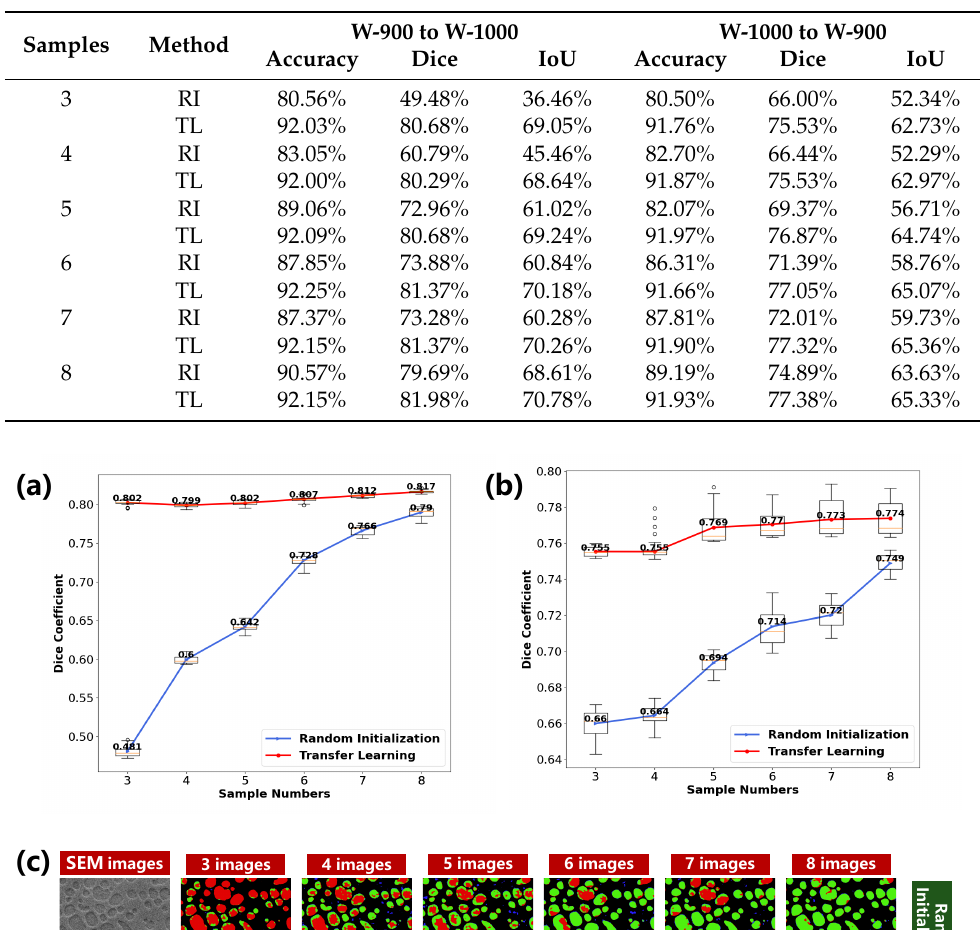
Table 2. Average results of deep transfer learning (TL) and random initialization (RI).